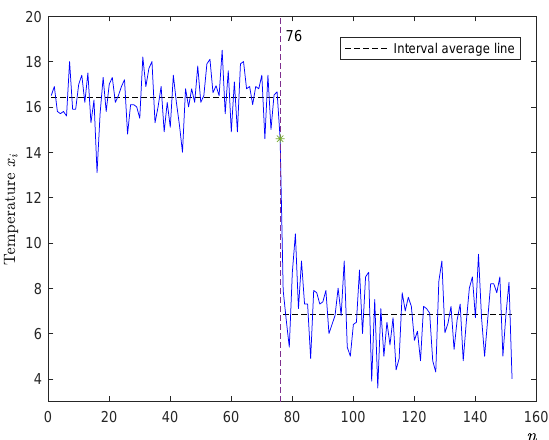
Figure 2. The plot graph of monthly mean temperatures based on June and October data.